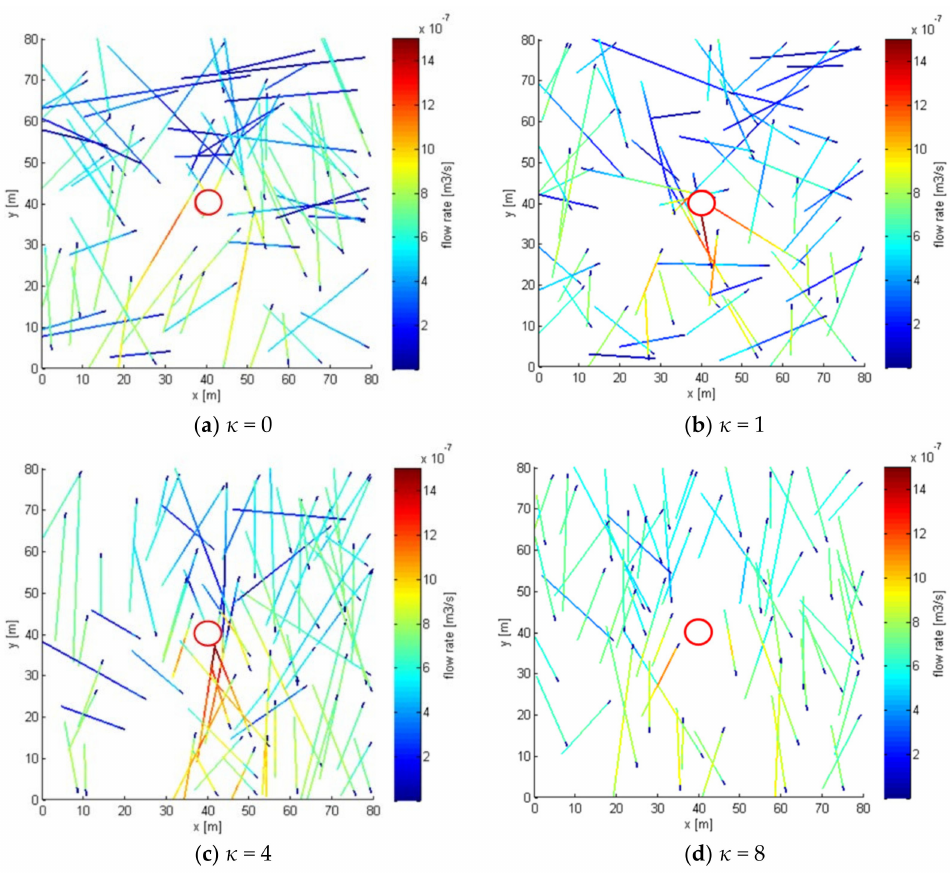
Figure 9. Fracture flow rate distribution under different κ